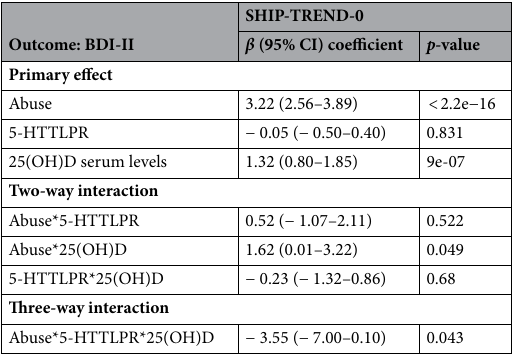
Table 2. Linear regression of BDI-II scores and different primary effects with robust estimates adjusted for age and sex in SHIP-TREND-0. For the effects including the 25(OH)D, the regression has additionally been adjusted for the body mass index, physical activity, smoking, and season. CI, confidence interval